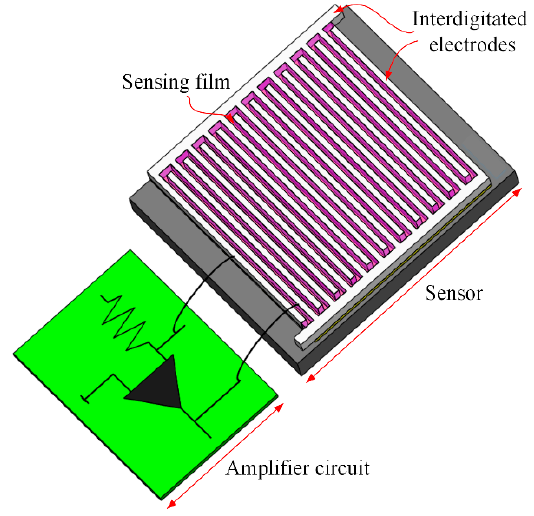
Figure 1. Ammonia gas sensor structure.